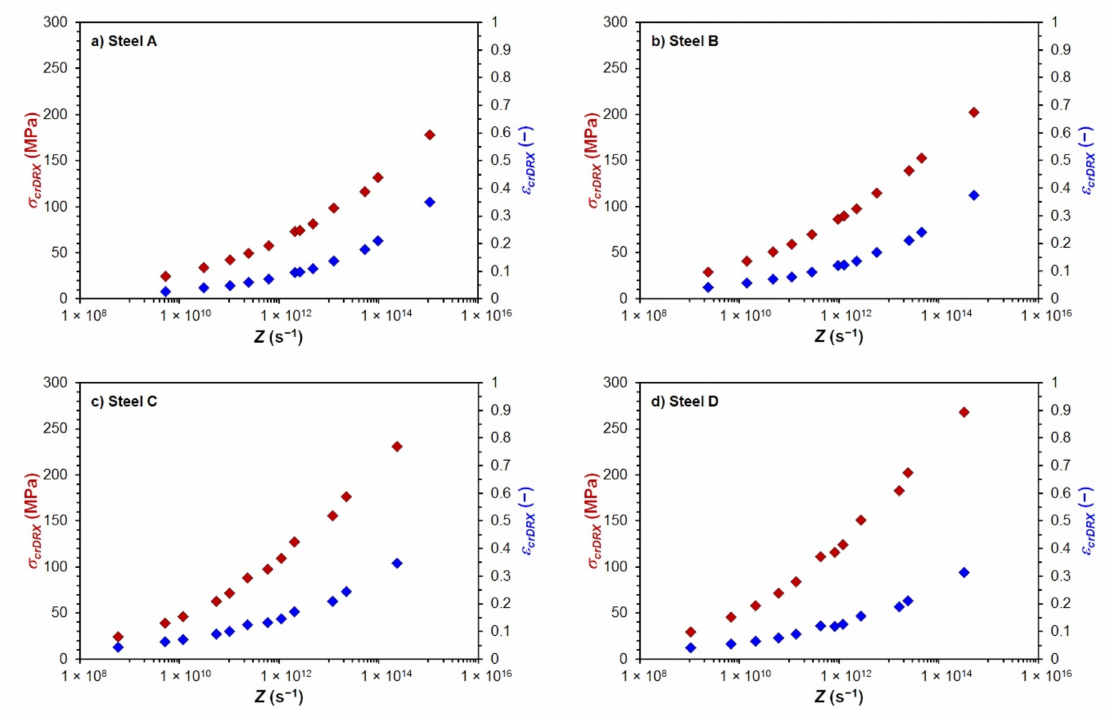
Figure 8. Dependence of determined values σ crDRX and ε crDRX on parameter Z : ( a ) steel A; ( b ) steel B; ( c ) steel C; ( d ) steel